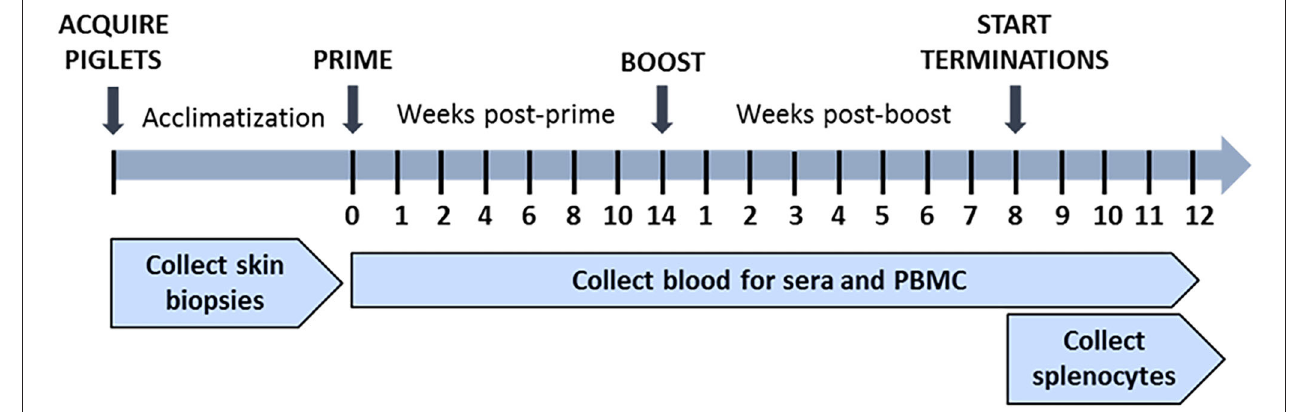
FIGURE 3 | In vivo study timeline. Piglets were acclimatized, and skin biopsies were collected prior to immunization. Piglets in treatment groups were primed at week 0 and then boosted at week 14 post-prime with the Ad-pp220 cocktail as shown in Table 1 . Negative control piglets were similarly primed and boosted, but with Ad-Luciferase. Pigs from all the groups were terminated after week 8 post-boost. Blood samples were collected weekly post-prime and post-boost for PBMCs and sera. During termination, blood samples were collected, and spleens were harvested.